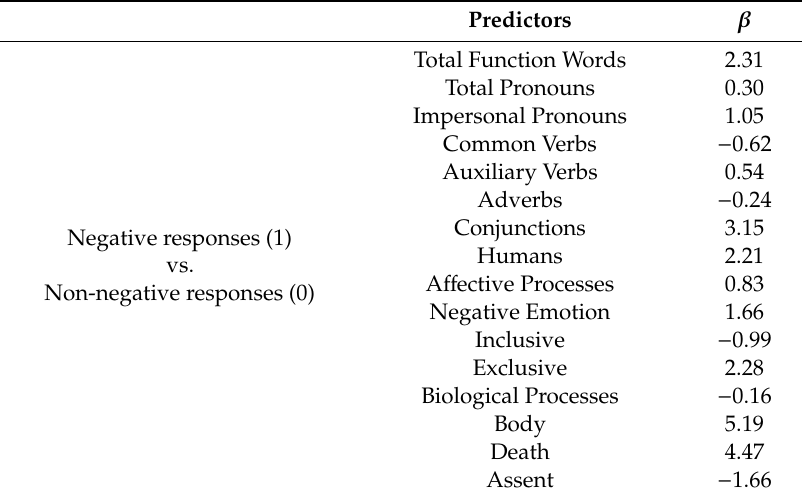
Table 6. Regression coe ffi cients in the Simple Logistic Regression